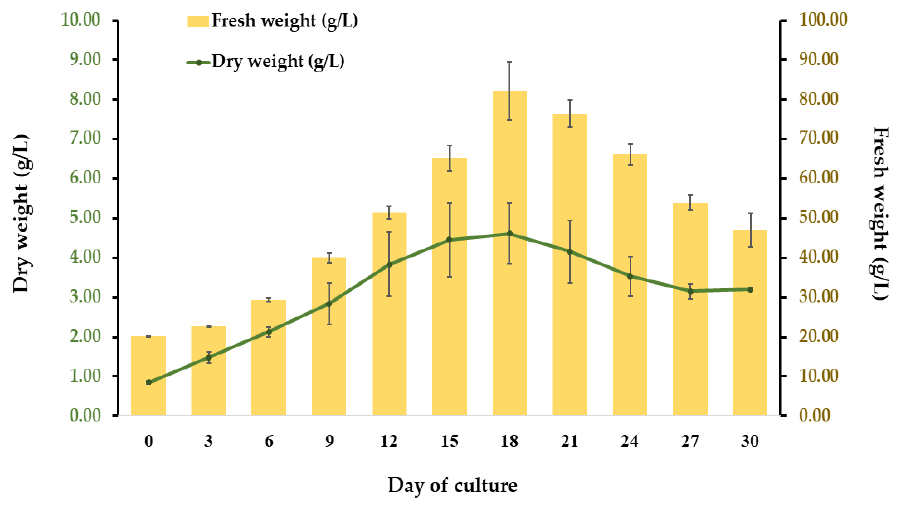
Figure 4. Growth profile of R. nasutus cell suspension cultures during 30 days of culture in liquid CIM.